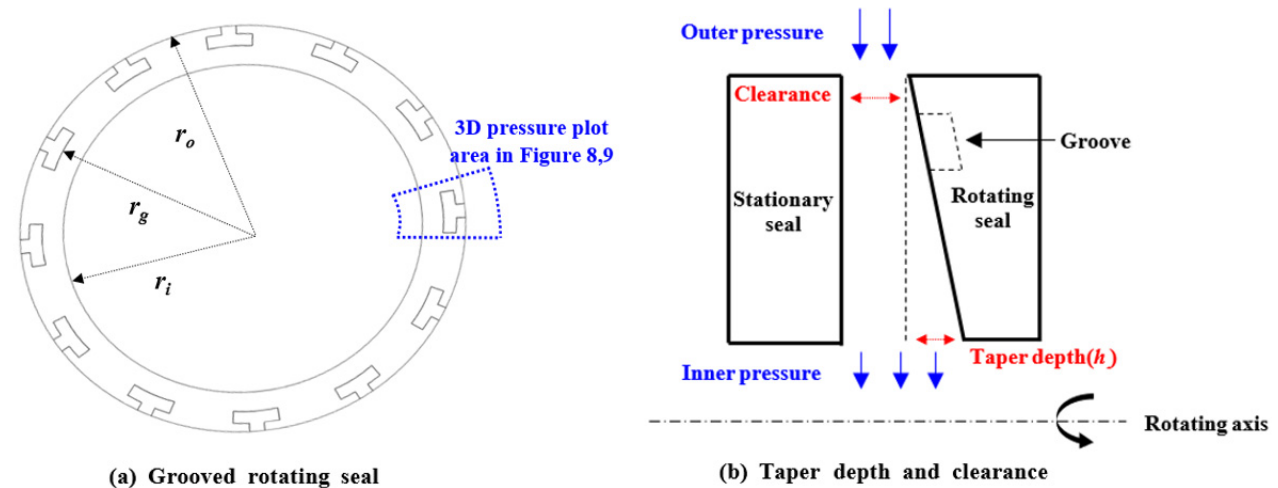
Figure 4. The rotating seal with T grooves used in the experiment.